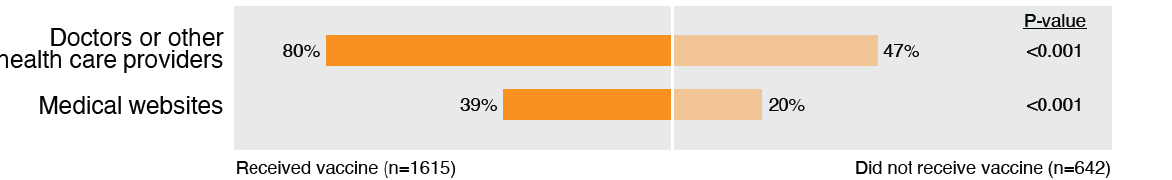
Figure 3. Differences in trust in healthcare and medical sources between vaccinated and unvaccinated EMS professionals.